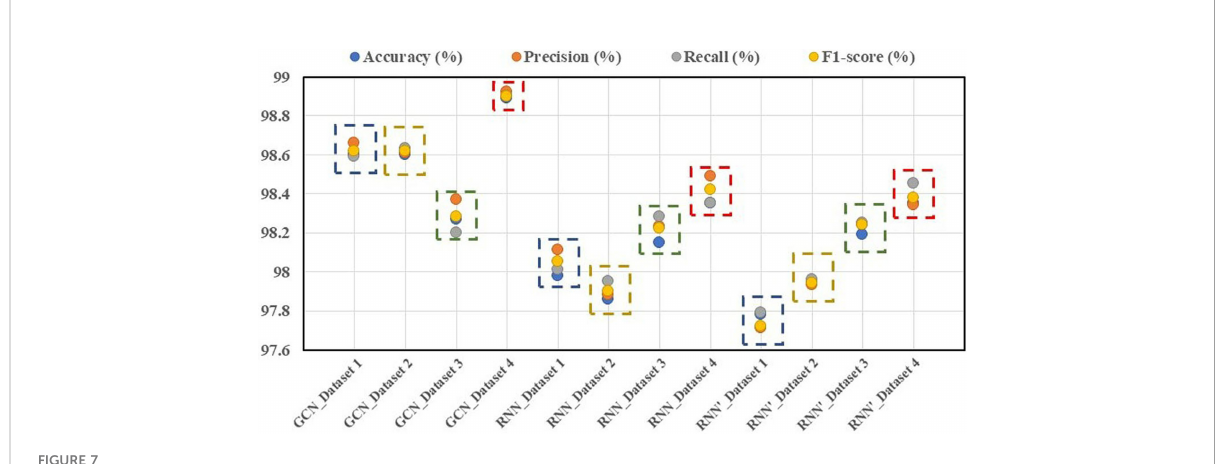
FIGURE 7 Fish appetite grading results under different